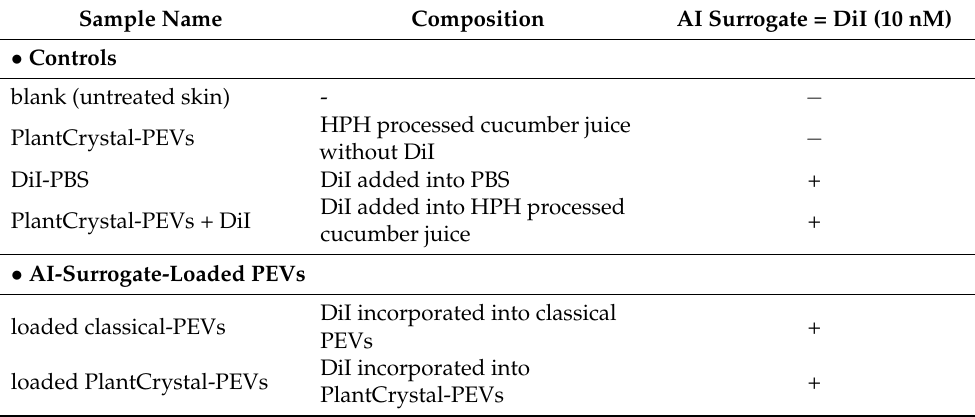
Table 1. Overview of formulations and controls tested on the ex-vivo porcine ear